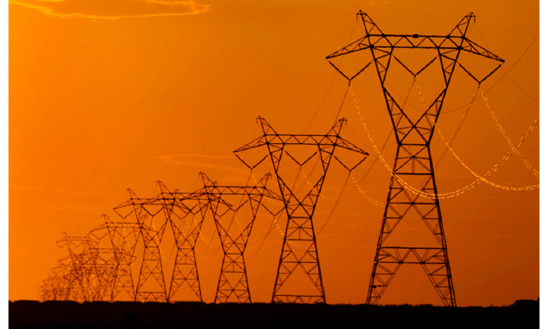
Figure 14. Curved transmission